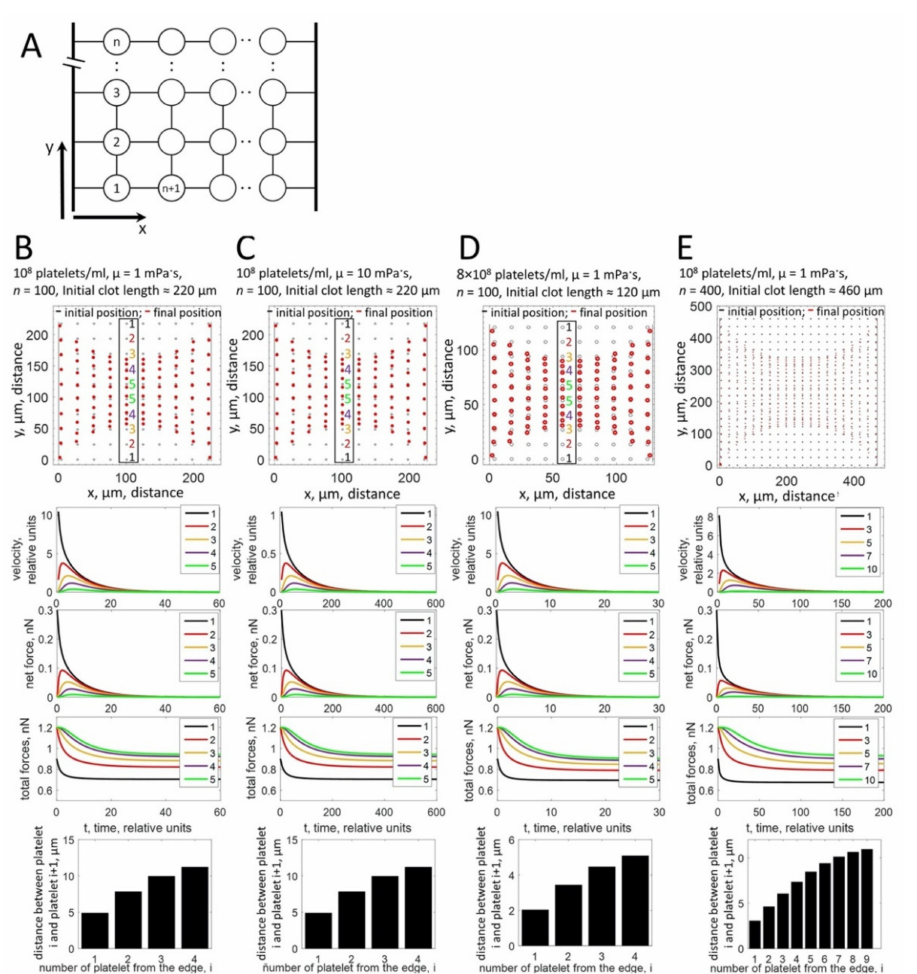
Figure 4. Computational modeling of platelet distributions in a two-dimensional, constrained clot. ( A ) Schematic rep- resentation of the modeled system. Platelets are depicted as circles, connected by elastic springs. Holders are modeled as stiff rods. The connection between a platelet and a holder is modeled as an elastic spring. ( B – E ) Upper panels: the modeling approach simulates the non-uniform distribution of platelets within the clot after contraction for different platelet concentrations, different viscosities of the fibrin network ( µ ), or different clot sizes as indicated on top of the panels ( B – E ). Black ovals—initial state of platelet distribution. Red ovals—platelet distribution after contraction. For the central part of the system (numbered platelets in the black box), platelets accumulate at the free periphery of the clot, while the distance between central platelets remains large. Middle panels: simulation of platelet velocities (first graph), net forces (the vector sum of forces that act on a platelet; second graph), and total forces (the algebraic sum of all forces that act on a platelet; third graph). Platelets at the free periphery of the thrombus move faster than platelets in the center. The platelet velocity decreases exponentially with time of contraction. Net forces that act on the peripheral platelets are higher than net forces in the center of the clot. For peripheral platelets, net forces are directed towards the center of the clot. For central platelets, forces acting in opposite directions are balanced and net force is close to zero. In contrast, total forces are higher in the center than in the periphery. Forces are not influenced by the viscosity ( µ ) of the fibrin network and the platelet concentration. Velocities decrease when the viscosity of the fibrin network increases. Lower graphs: the calculation of distances between pairs of platelets in the central column (platelets in the black box in upper panels of ( B – E )) shows that the distance between platelets at the border (bar 1) is significantly smaller than the distances between platelets in the center (bar 4 or